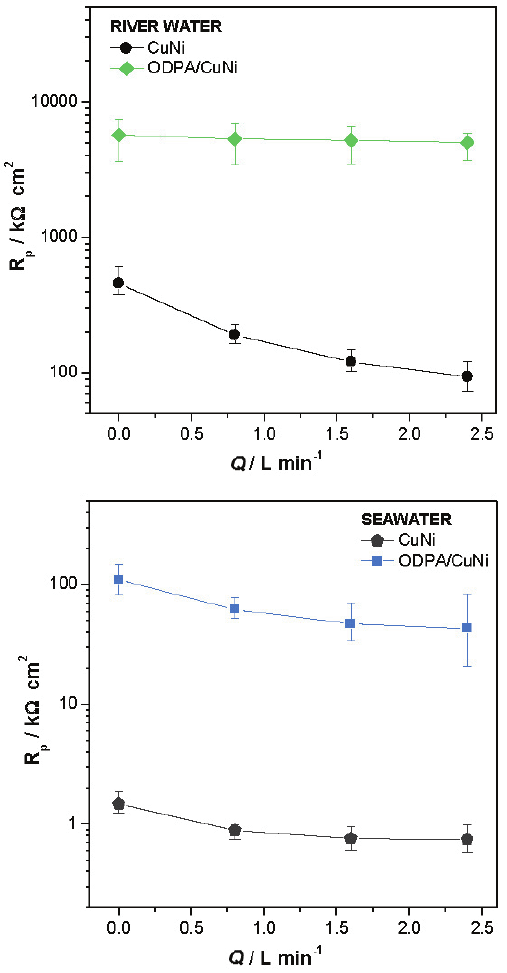
Fig. 2 – Polarization resistance dependence on river and seawater flow rate for untreated and ODPA-modified cupron- ickel